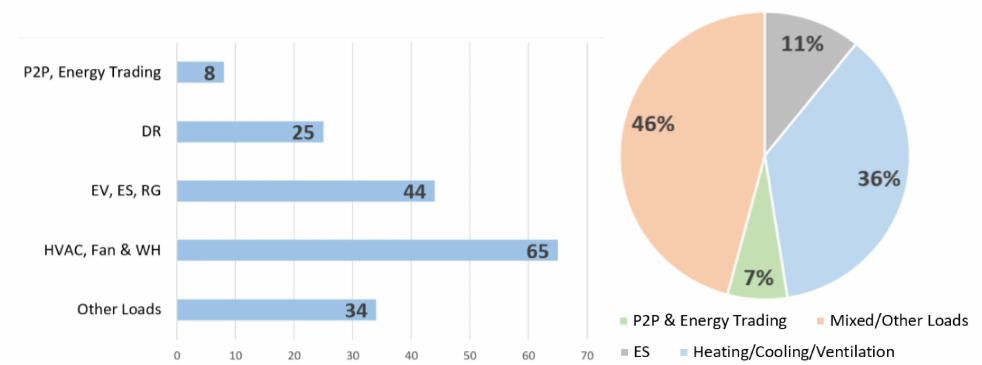
Figure 14. Application Classes. The total number of articles in each application class ( left ), as well as their corresponding proportions ( right